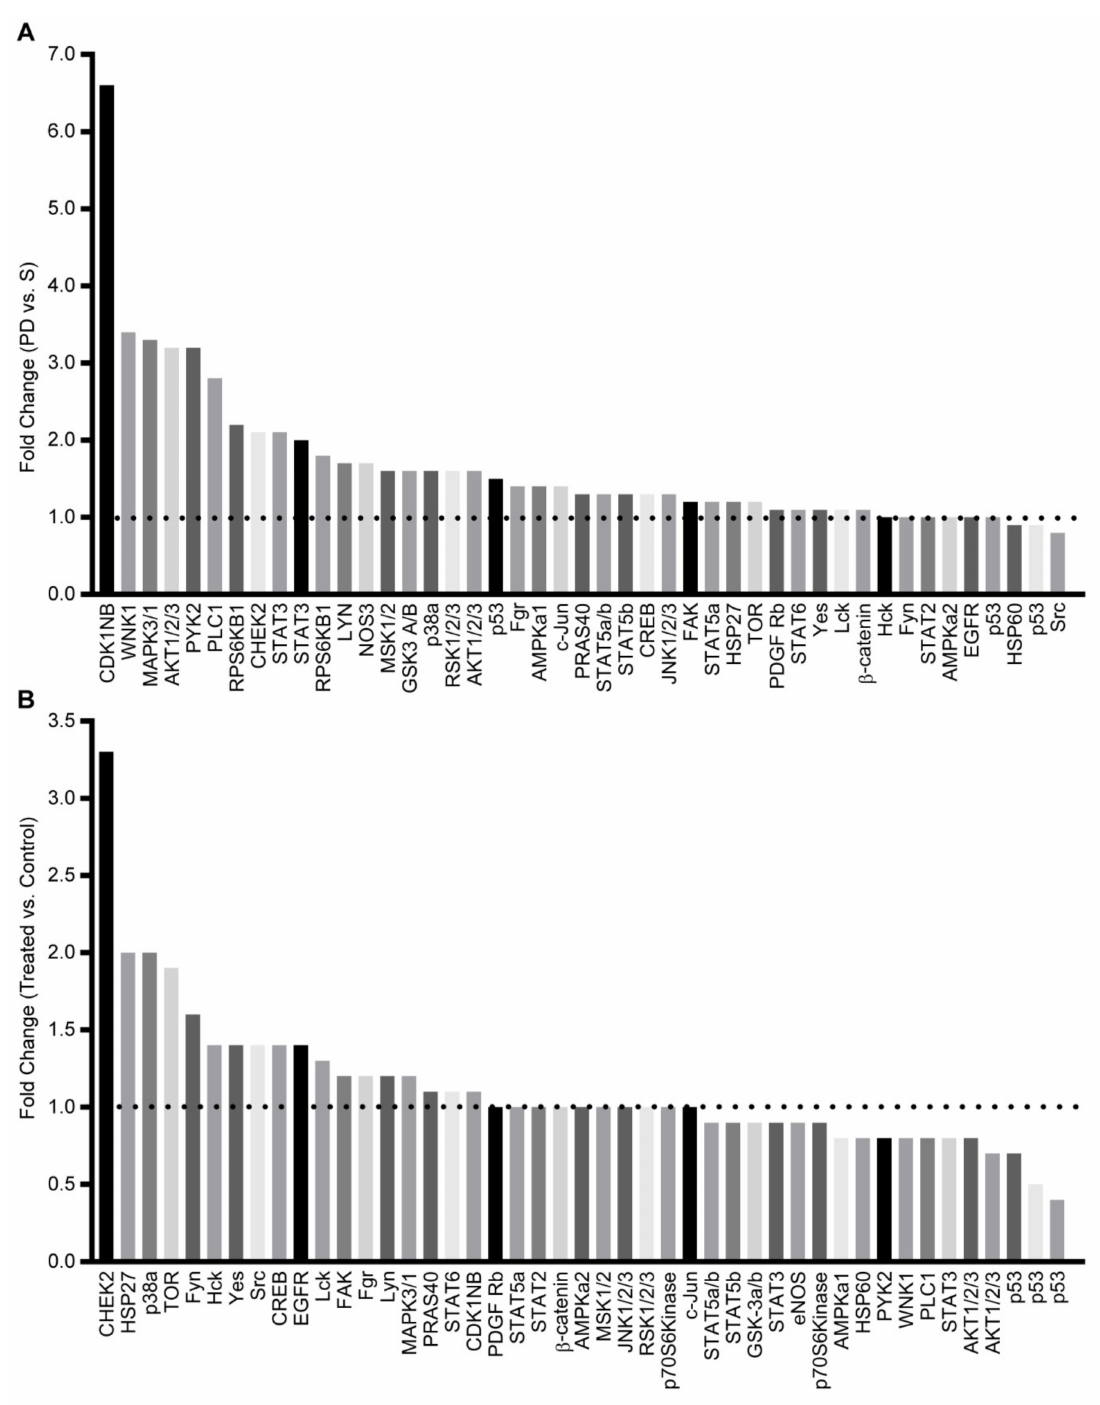
Figure 1. Activation of survival signaling pathways in drug-resistant phase dim (PD) cells. ( A ) REH cells were co-cultured with BMSC, the S and PD ALL cells were isolated, and the phosphorylation of protein kinases was compared with the PD expression level compared to the S sub-population. ( B ) REH cells were co-cultured with BMSC and left untreated (control) or treated with MK-2206. The PD REH tumor cells cultures were isolated from the control and MK-2206 cultures, and the relative level of protein kinase phosphorylation was